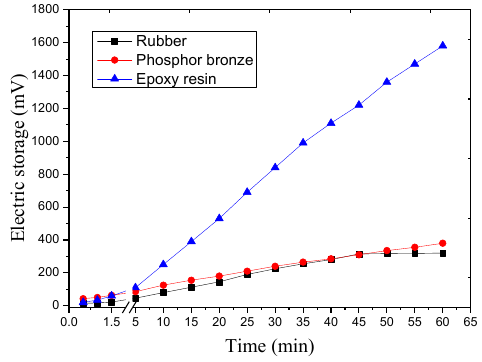
Figure 11. Output voltage of the different materials.